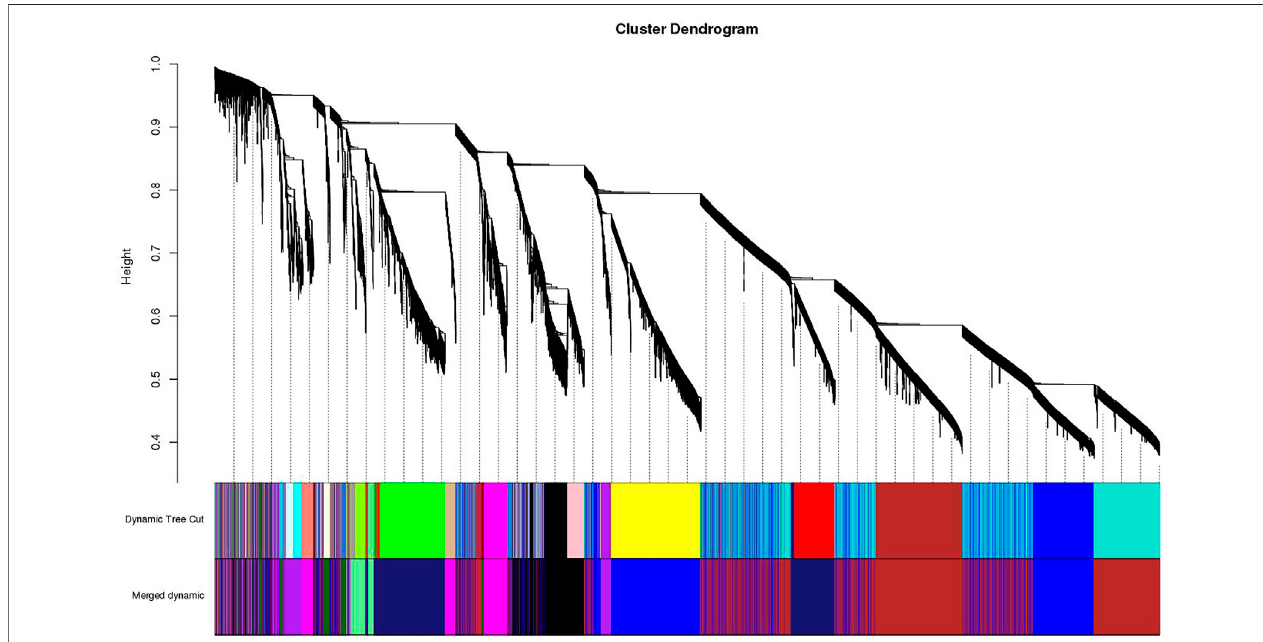
FIGURE3| Clusteringdendrogramofgenes,withdissimilaritybasedontopologicaloverlap,togetherwithassignedmergedmodulecolorsandtheoriginalmodule colors.